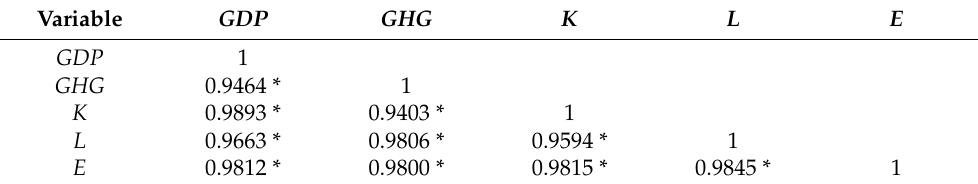
Table A1. Pearson correlation